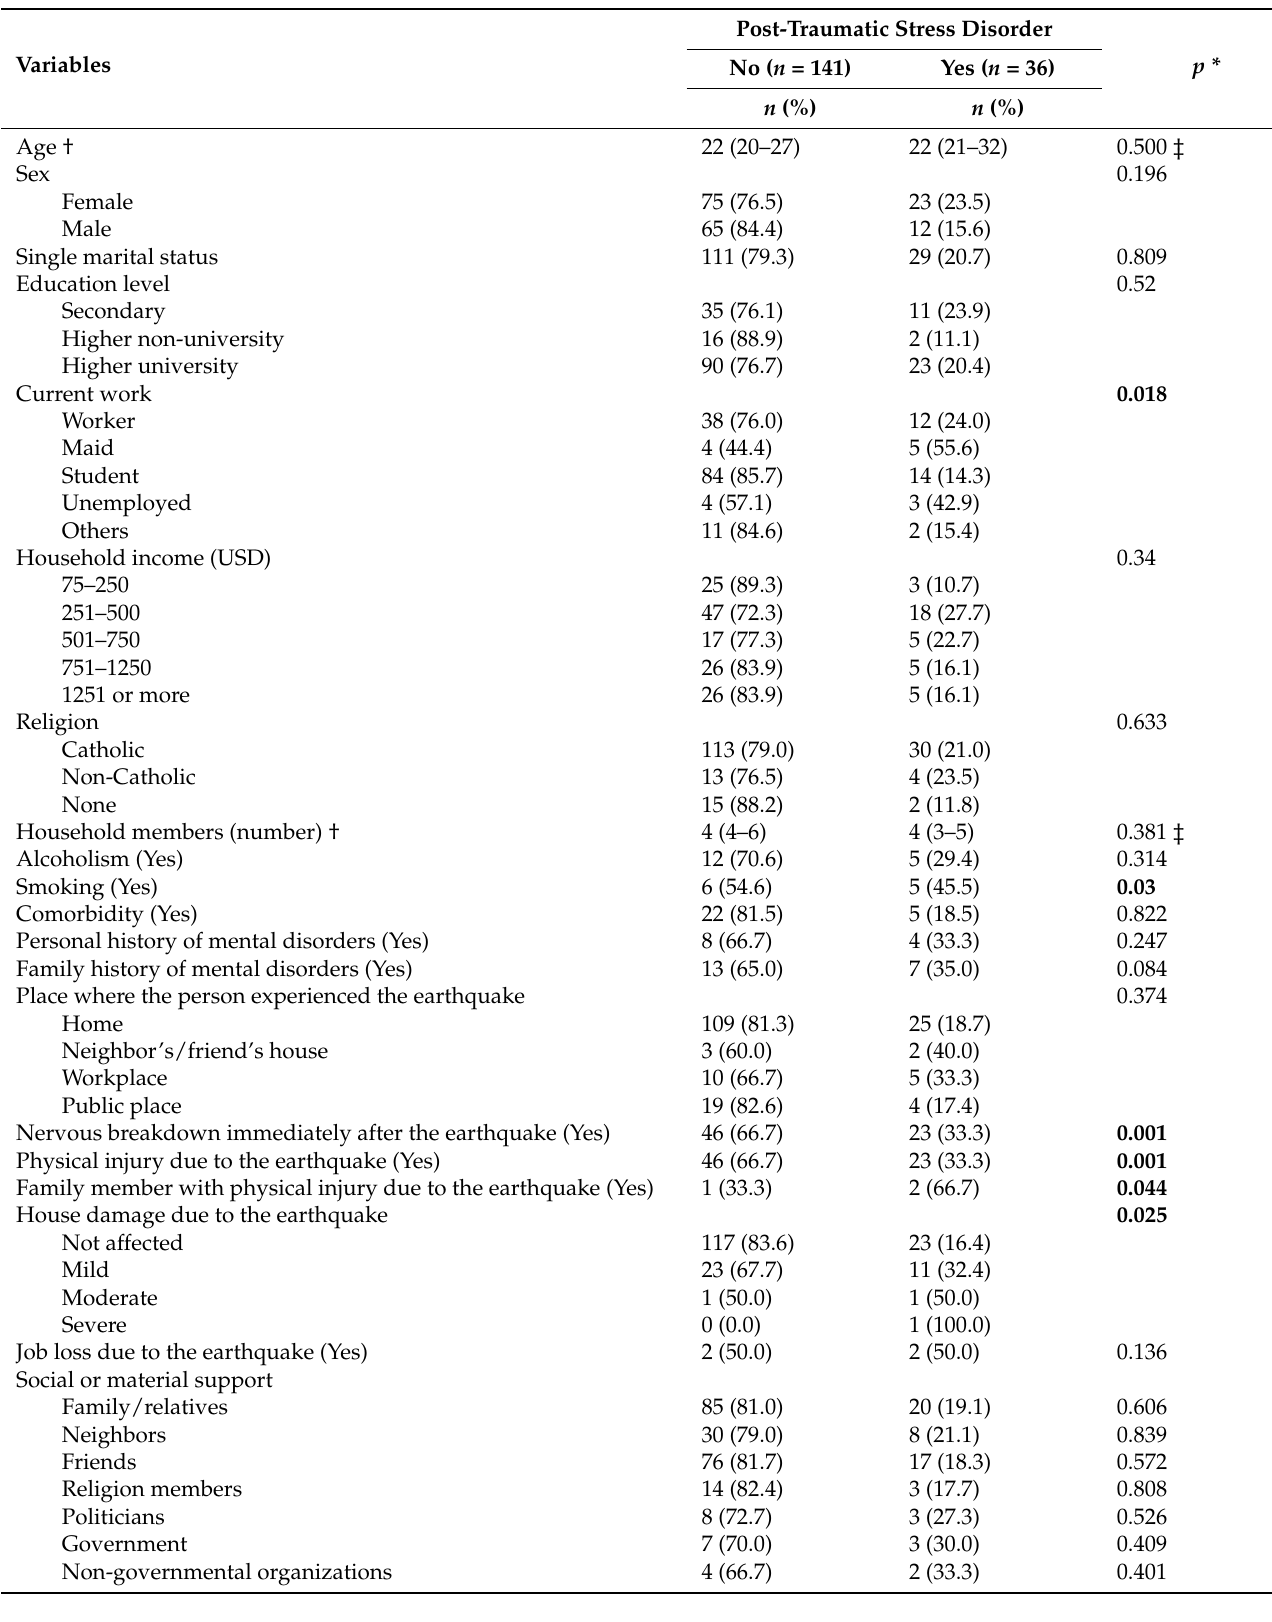
Table 2. Characteristics associated with